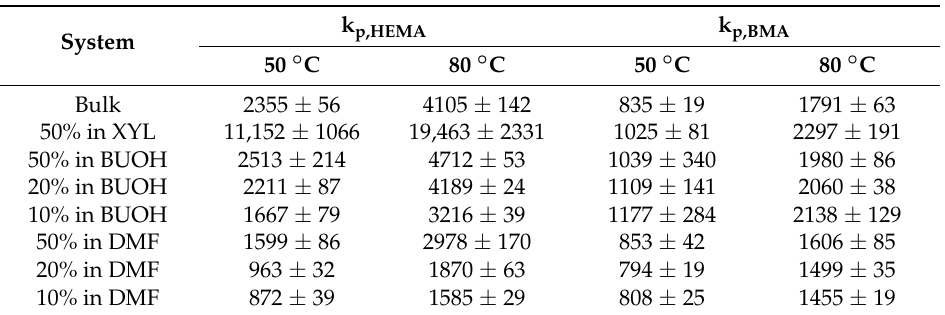
Table 4. Homopropagation k p (L/mol s) values (with 95% confidence intervals) estimated by fitting of the terminal model to BMA/HEMA k p,cop data obtained in xylene (XYL), butanol (BUOH), and DMF solution at 50 and 80 °C, with reactivity ratios for each system taken from Table 2. Percentage values represent the vol% of comonomer mixture in the solvent.